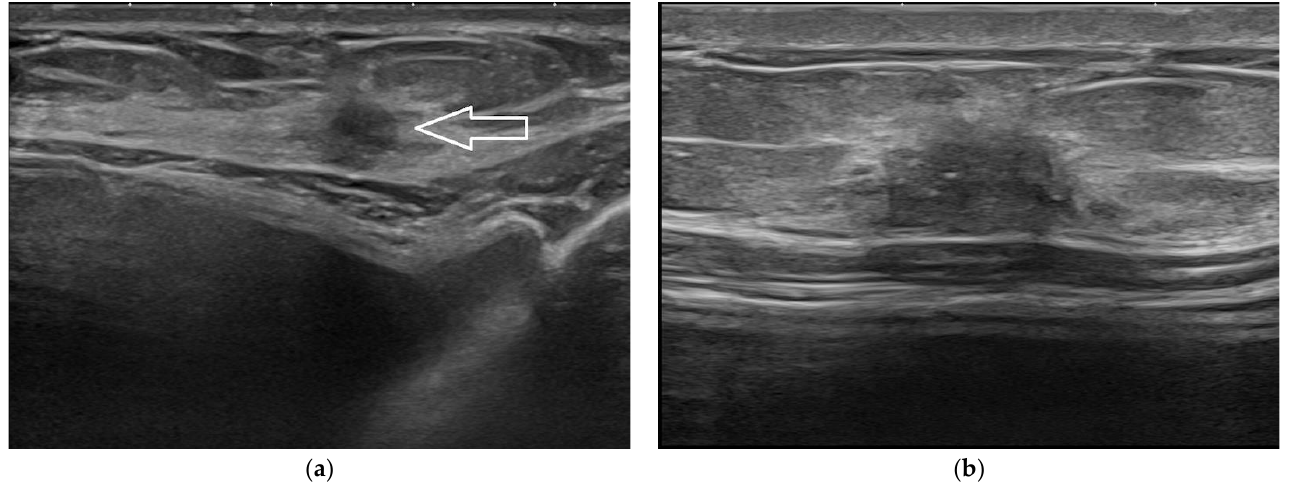
Figure 10. An irregular distortion detected in a patient with a history of breast augmentation sur- gery and a submuscular implant ( a , arrow). The lesion is better displayed at 22 MHz ( b ), where the spiculated margins, the hyperechoic desmoplastic border, and the internal echoic spots due to mi- crocalcification are better appreciated. Histology confirmed an invasive ductal carcinoma.